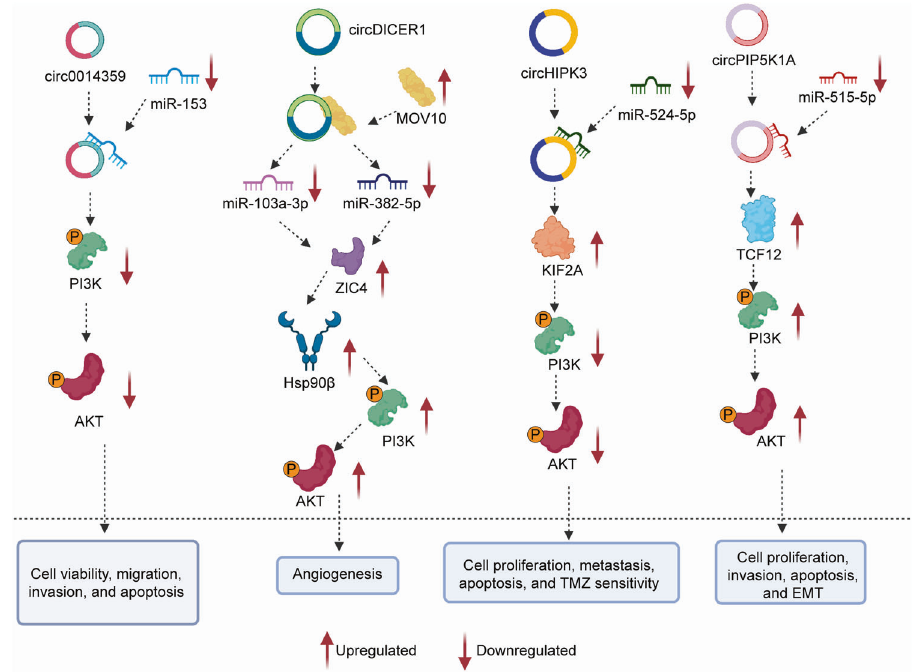
Fig. 3 The speci fi c mechanism of glioma progression between circRNAs and PI3K/AKT pathway. Circ0014359 exerts its effects by inhibiting the level of miR-153 and regulating the PI3K/AKT axis. CircDICER1 in combination with MOV10 plays a critical role in glioma angiogenesis via regulation of miR-103a-3p (miR-382-5p)/ZIC4. CircHIPK3 regulates biological functions to improve sensitivity to temozolomide through suppression of the miR-524-5p/KIF2A-mediated PI3K/AKT pathway. circRNAs can also facilitate glioma tumorigenesis and progression